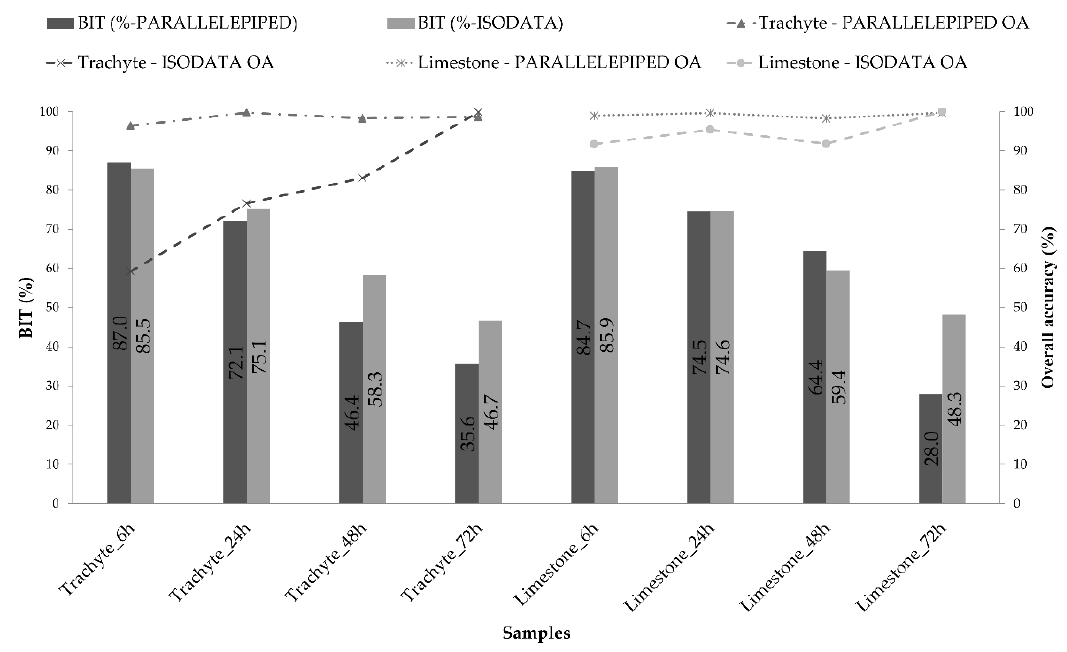
Figure 5. BIT computation by the Parallelepiped and the ISODATA algorithms. The parallelepiped method shows lower standard deviation values (1.38 for trachyte and 0.68 for limestone) than those obtained using the ISODATA method (16.80 for trachyte and 3.91 for limestone). For limestone mixtures, confusion matrices show the average overall accuracy (sum of the number of correctly classified values divided by the total number of values) and k-coefficient (measurement of the agreement between truth values and classification) for all rolling-bottle steps of 94.7% (k = 0.91) and 99.1% (k = 0.98) for ISODATA and parallelepiped, respectively. For trachytic mixtures, confusion matrices show average overall accuracy and k-coefficient of 79.7% (k = 0.72) and 98.3% (k = 0.97), respectively. The parallelepiped algorithm seems the most suitable technique to assess the BIT value for trachytic aggregates, while both techniques show remarkable results for both kinds of aggregates. Generally, higher overall accuracies are obtained for both aggregates with the parallelepiped algorithm. 3.3. Spectroscopy The two VIS–NIR spectrometers were used to acquire spectral images of trachyte and limestone mixtures at 6, 24, 48 and 72 h. Once the dataset was developed, the hyperspectral cube was computed to manage and classify images. The number of images acquired by each camera was different because the frame rate of the two cameras was set to two different values, therefore more images were acquired by the sensor camera (frame rate equal to 50 fps) than by the Falcon camera (frame rate equal to 25 fps). By positioning the VIS spectrometer scan line perpendicular to the advancement direction of each sample, an image was obtained where each row (or column for NIR camera) represents the section of the scanned surface at a given wavelength. Through the initial step of the geometric calibration, a wavelength λ could be associated with each column of the image. The hyperspectral cube was processed using the ENVI ® (Environment for Visualizing Images, L3Harris Geospatial, Boulder, CO, USA) software program for visualization, analysis, and classification of digital images. Radiometric calibration was performed to remove the dependence of the spectra on the measuring instruments. In fact, the acquisition system did not record the reflectance of the material but the radiance value, i.e., the part of the radiation reflected by the material that reaches the sensor and has sufficient energy to be recorded. Absolute reflectance can only be calculated if the radiation incident on the material is known. Since